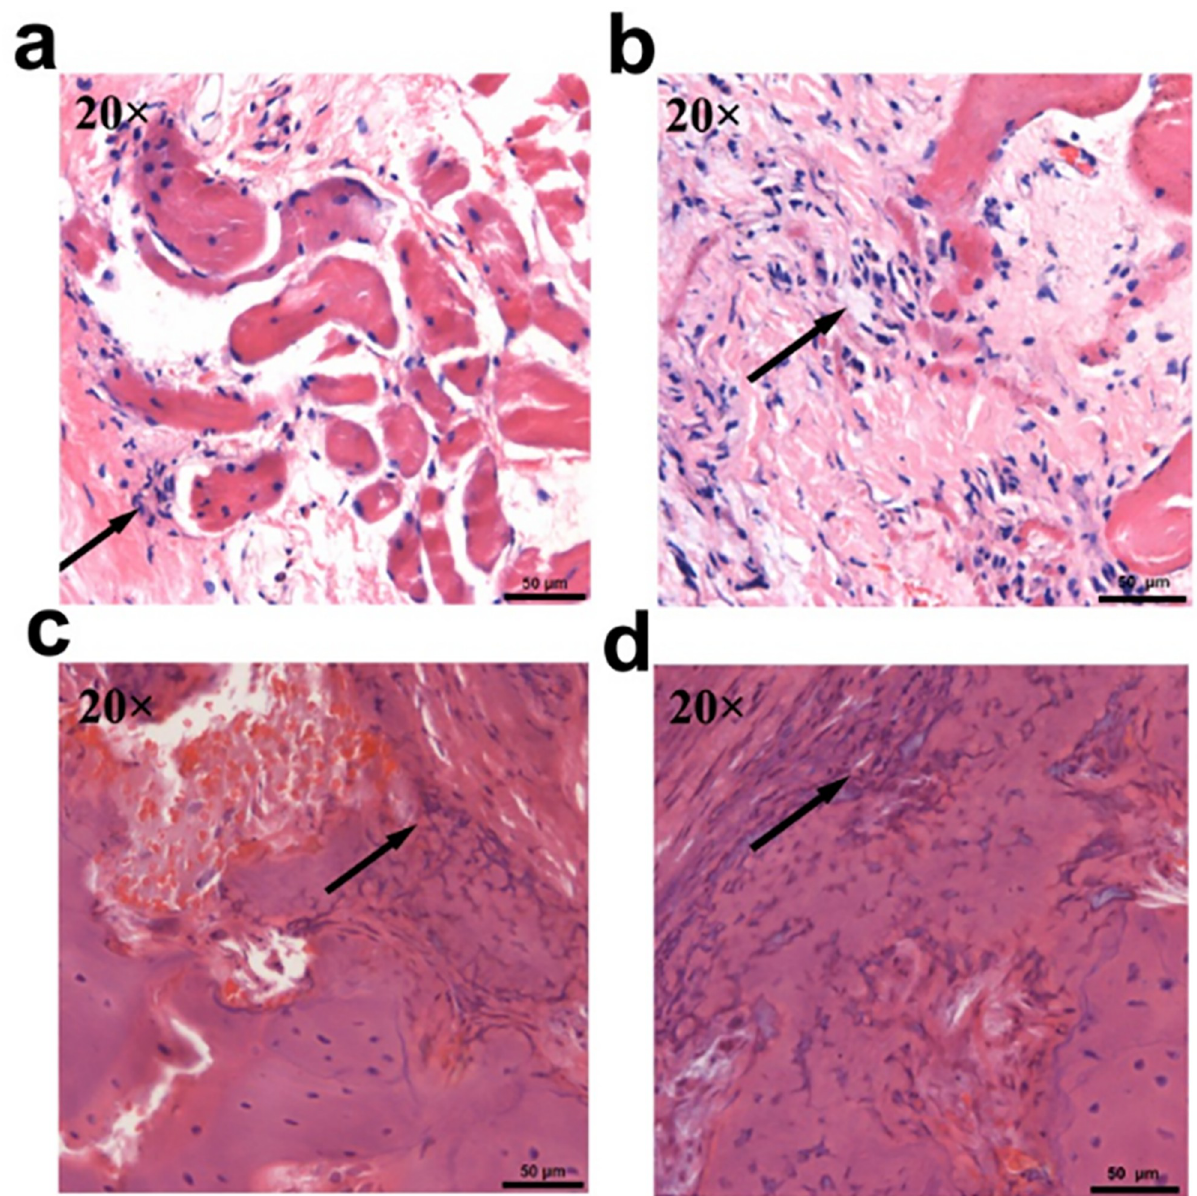
Fig 7. Histological observations of (a) muscle and (c) bone tissue in the control group and (b) muscle and (d) bone tissue in the infected group in the 4th week after model generation. The black arrows represent inflammatory cells (scale bar = 50 μ m; n = 3 rabbits per group). (CMs: Chitosan microspheres; GM: Gentamycin; β -TCP: β -tricalcium phosphate).